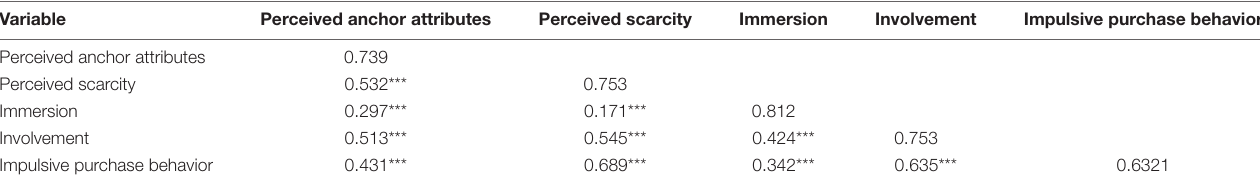
TABLE 5 | Analysis of discriminant validity.